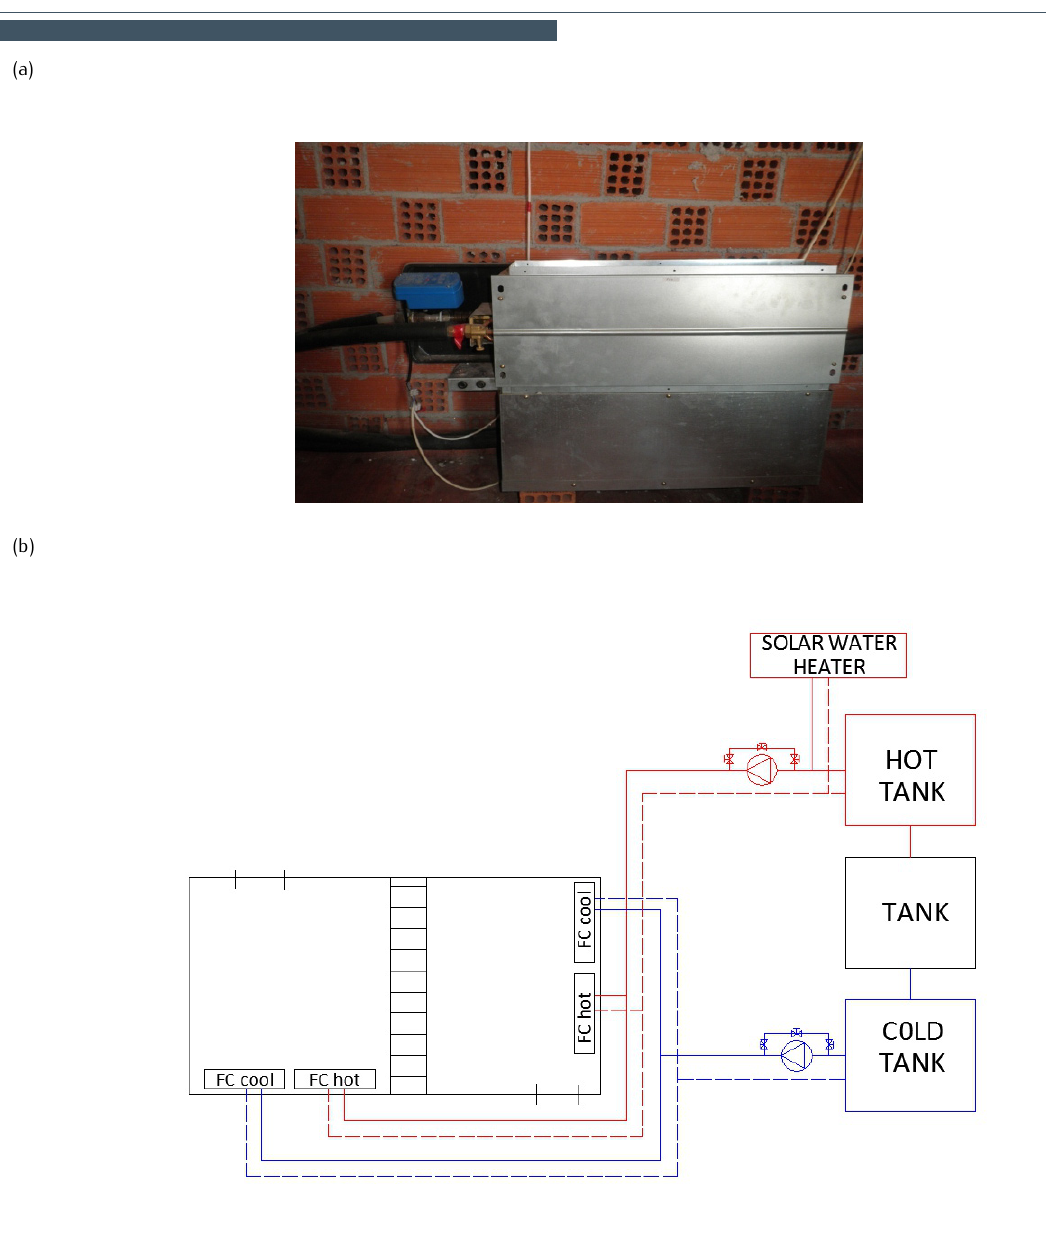
Figure 4. (a) Fan coils; (b) Fan coils connection with